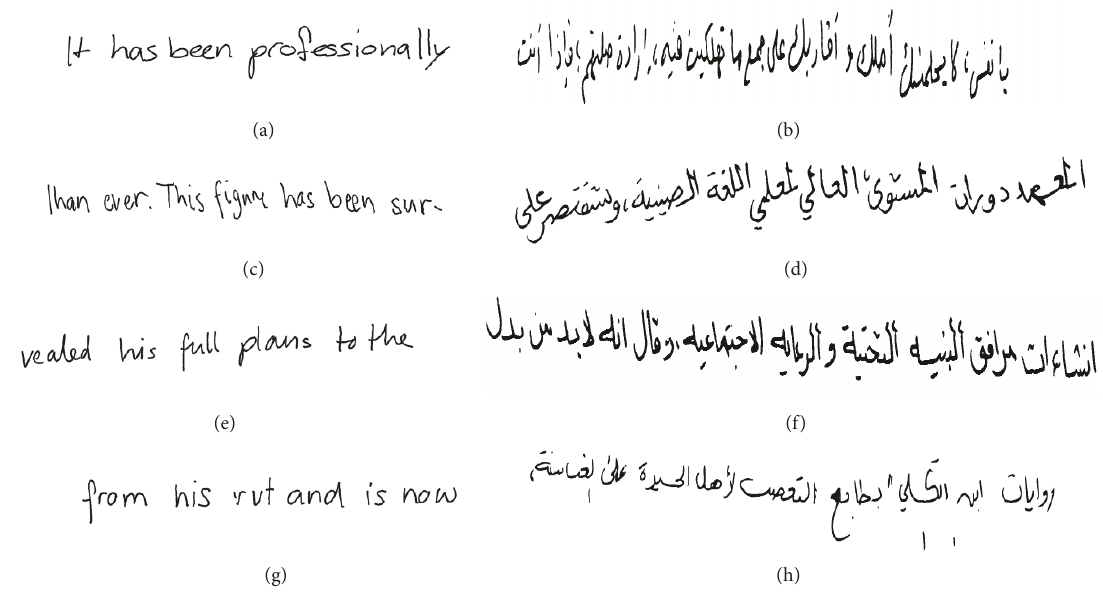
Figure 1: Some samples of handwritten text lines in English from IAM database (a, c, e, and g) and in Arabic from KHATT database (b, d, f, and h). These texts were written by (a)-(b) right-handed male, (c)-(d) left-handed male, (e)-(f) right-handed female, and (g)-(h) left-handed female,